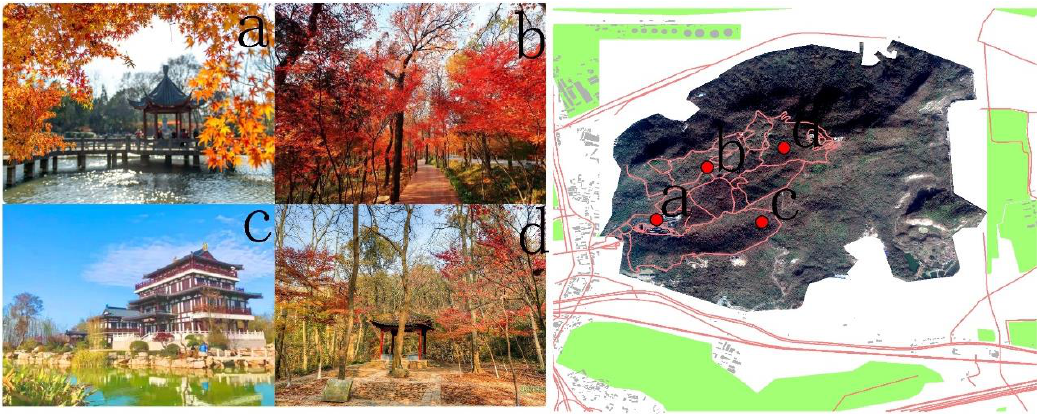
Figure 4. Some of the ground photos ( a – d correspond to the ground location).